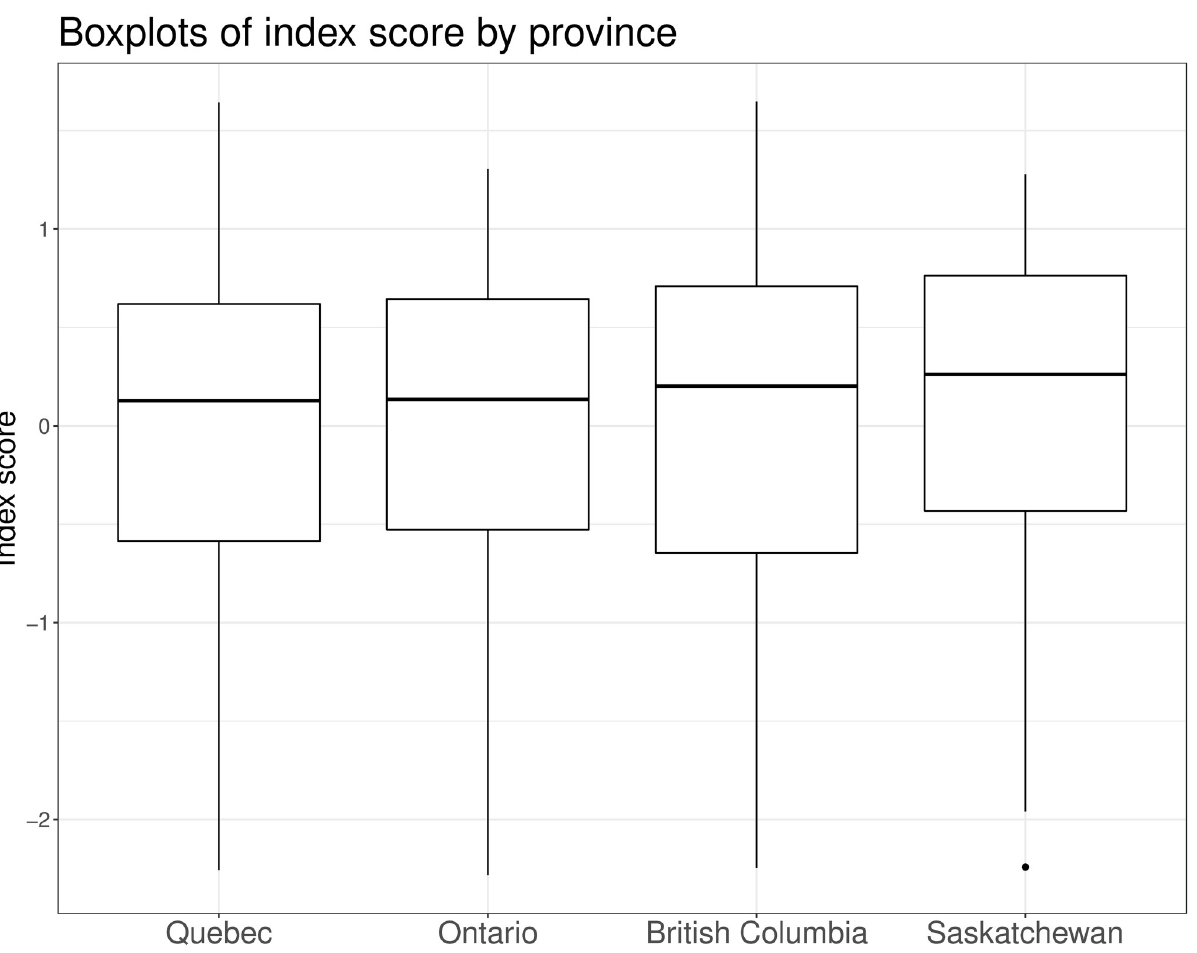
Fig 1. Boxplot of index scores by province. Posterior summaries of the individual scores for each participant presented as boxplots.